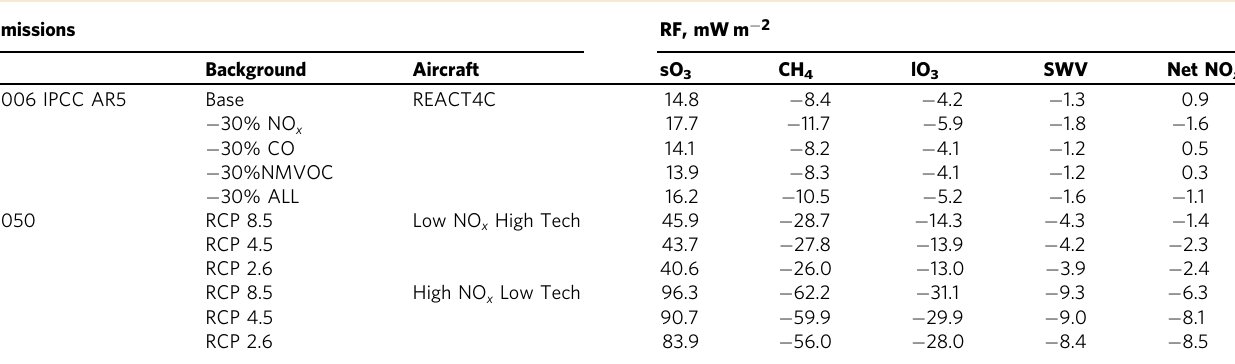
Table 2 The recalculated aircraft NO x radiative forcing (RF) from Table 1 using a revised simpli fi ed expression for the RF of CH 4 as presented by Etminan et al. 23